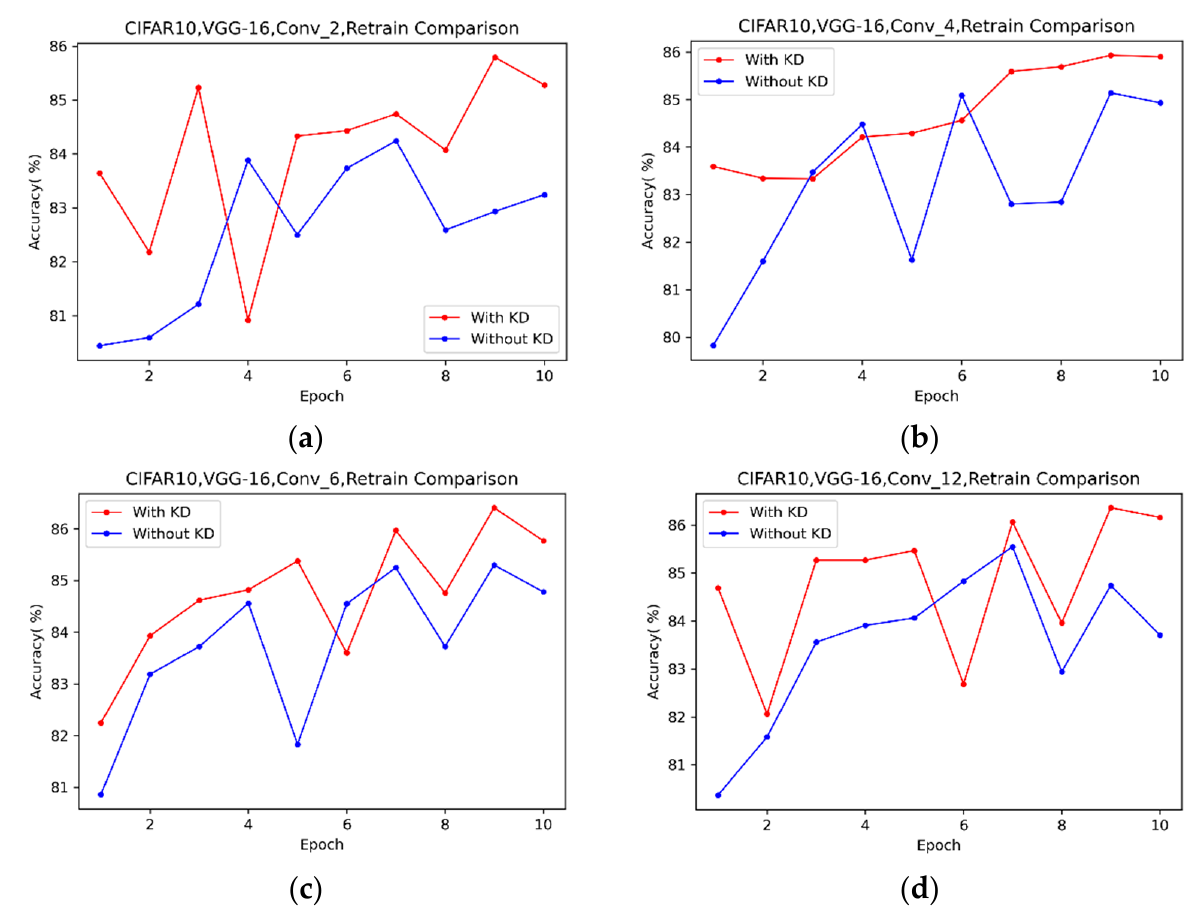
Figure 9. Short-term training results. This figure shows the differences in the accuracy recovery speed of VGG16 on CIFAR10’s various convolution layers in short-term retraining. The convolutional layers pruned in subfigures ( a – d ) are all from the same VGG16 but with different filter numbers.